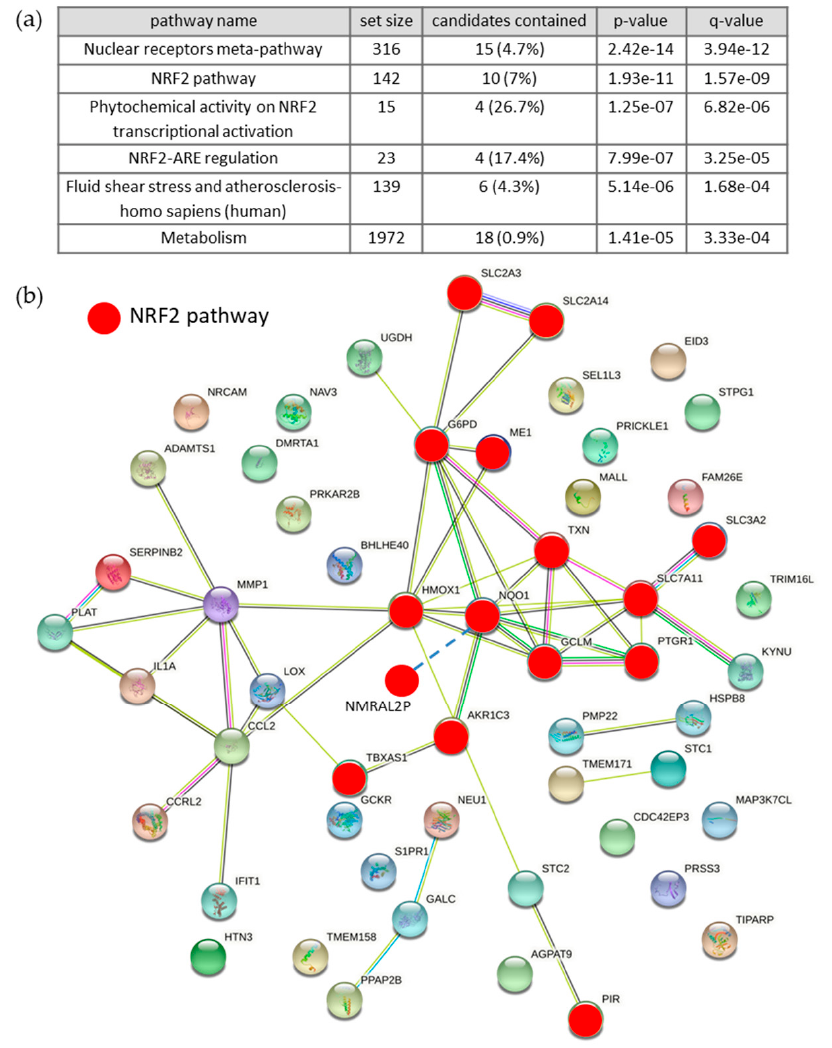
Figure 1. Analyses of up-regulated RNAs: ( a ) Functional annotation analyses of up-regulated genes for the identification of enriched pathways (cpdb.molgen.mpg.de; release 34; [20]). ( b ) Network analysis of up-regulated RNAs. Interaction map of the NRF2-target genes within the network are highlighted in red. The network was built utilizing the Gene String online tool (https://string-db.org; STRING 11.0b; 26 November 2020